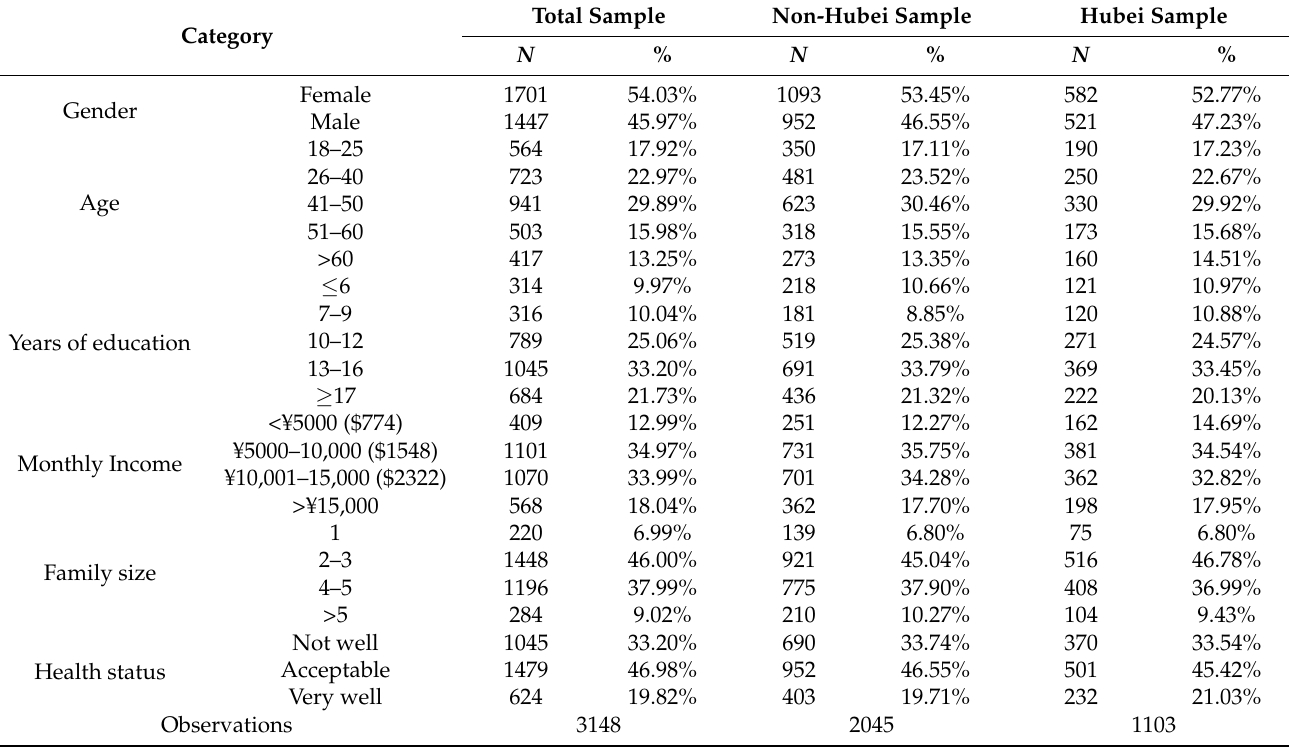
Table 3. Samples’ demographic information.